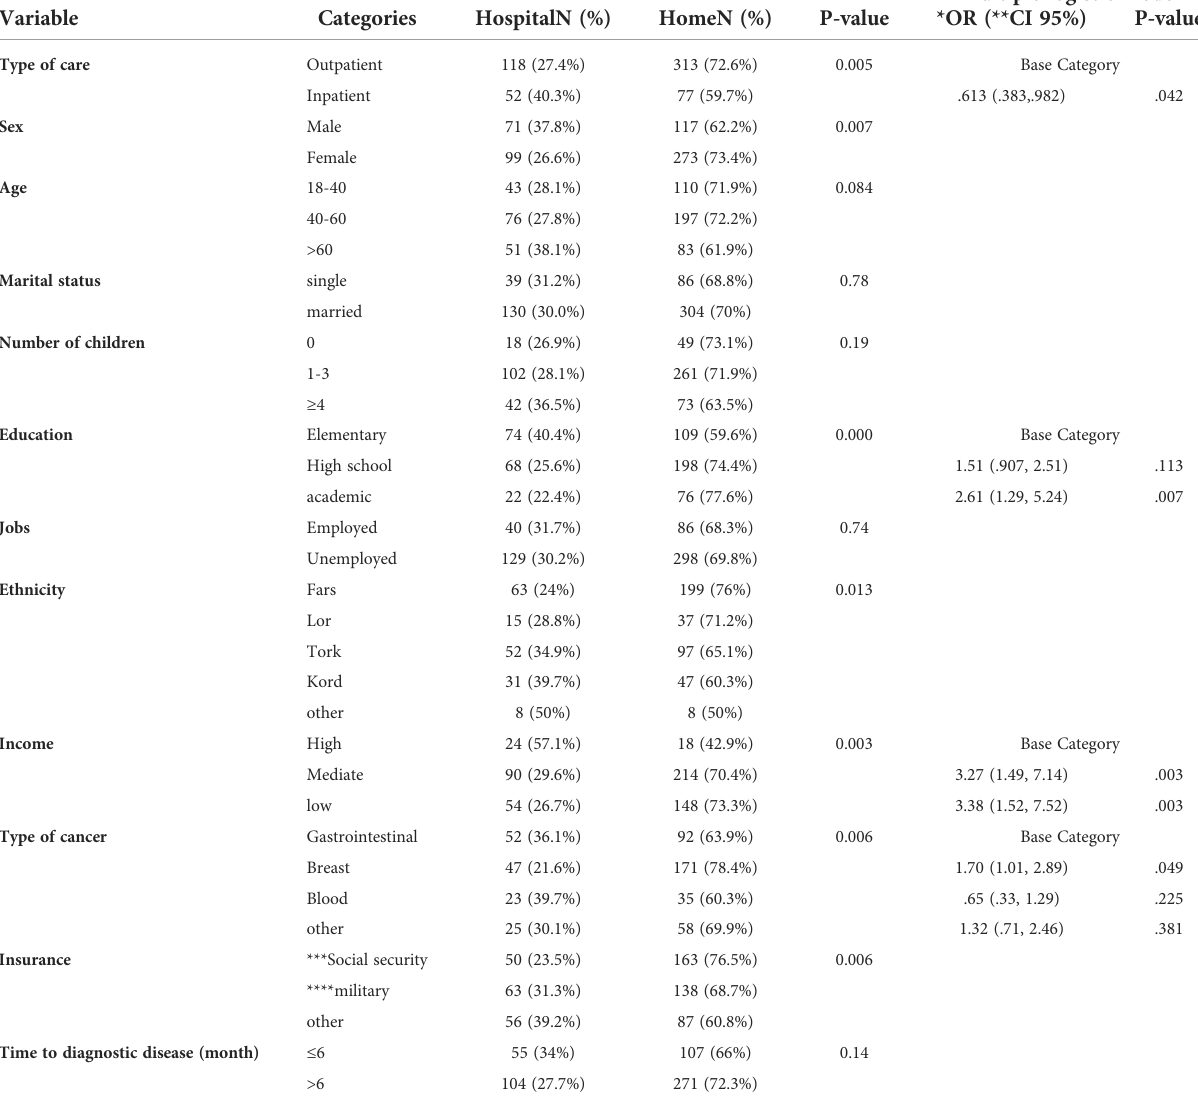
TABLE 2 Correlations between variables and the preferred place of end-of-life care in cancer